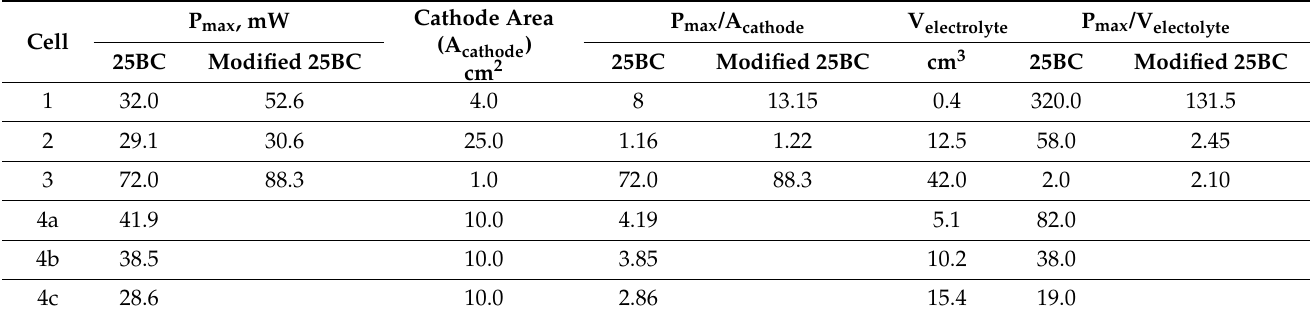
Table 4. Area power density and volumetric power density results for